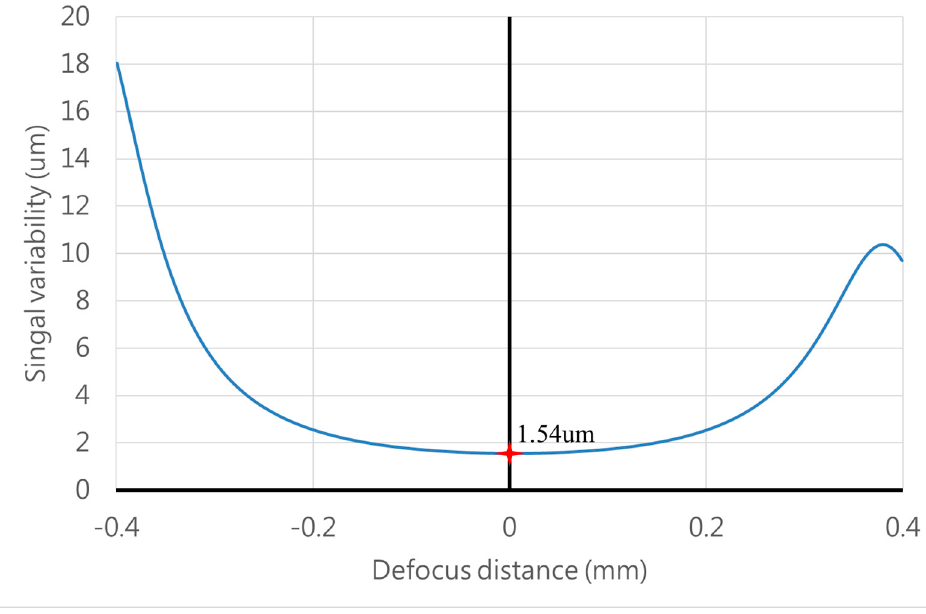
Figure 6. The relationship between the focus error signal (FES) and the defocus distance. Sensors 2020 , 20 , x FOR PEER REVIEW Table 3. Our simulation of the optimal parameters for the rear focal point.